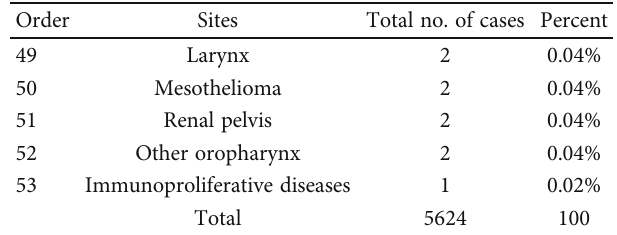
Table 1: Proportion of cancer sites in females aged 15-39 years from 2009 to 2016 in descending order ( N = 5624